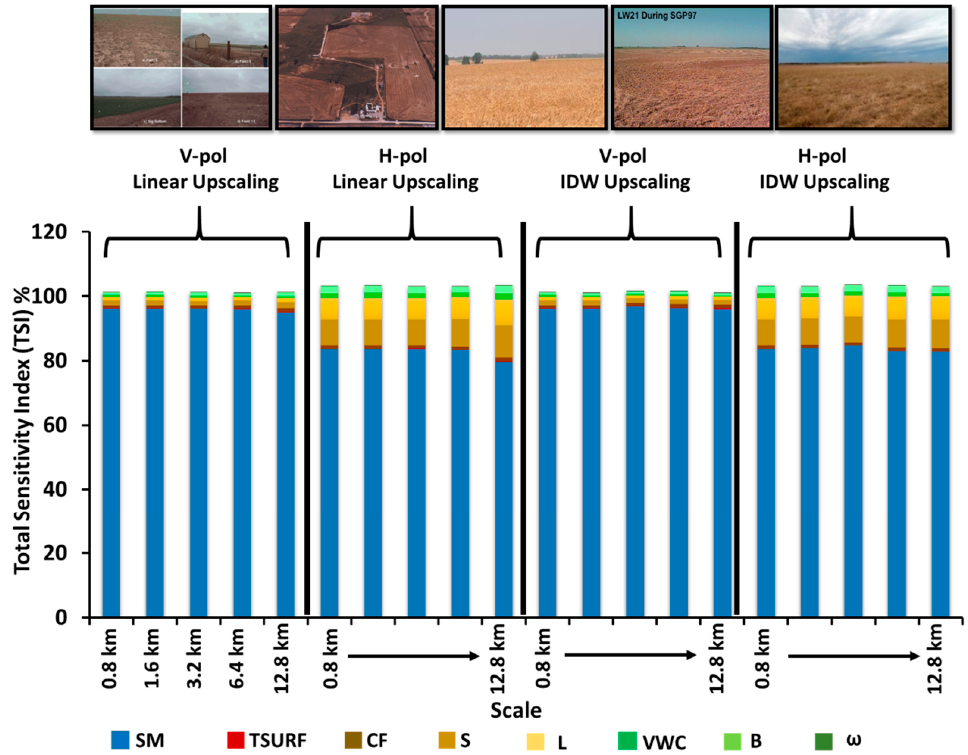
Figure 4. Southern Great Plains 1997 (SGP’97), Total Sensitivity Index (TSI) for Brightness Temperature under V-polarization, and H-polarization using Inverse Distance Weighted (IDW) and Linear Upscaling. SM: Soil Moisture; CF: Clay Fraction; S: Root Mean Square Height; L: Correlation Length; TSURF: Surface Temperature; VWC: Vegetation Water Content; B: Vegetation Structure; ω : Single Scattering Albedo.